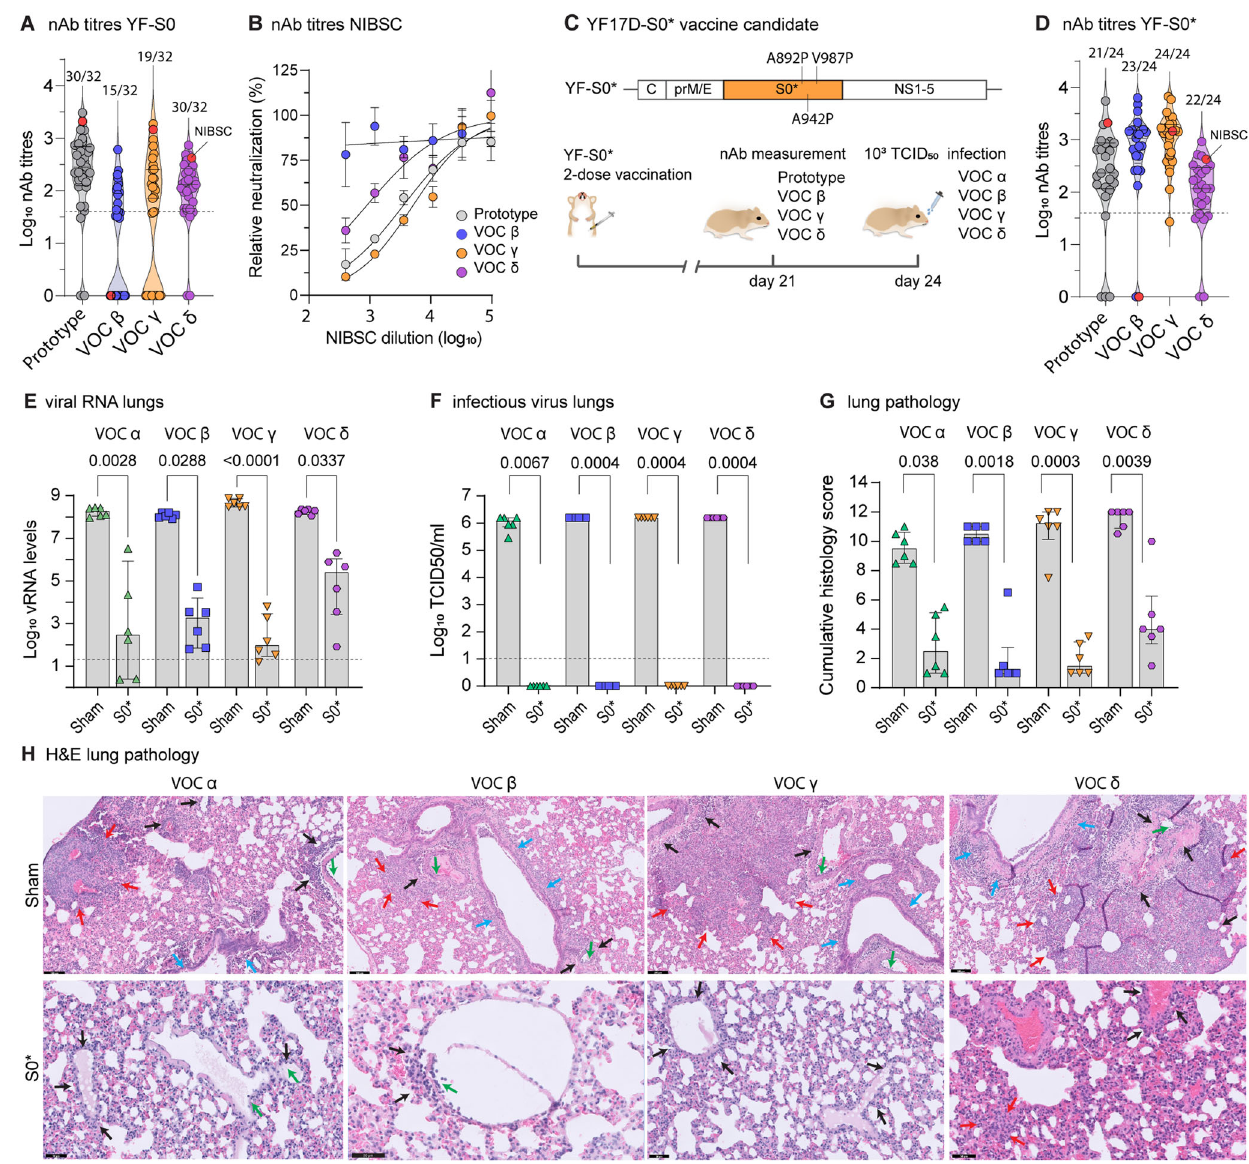
Fig. 2 | A vaccinebasedon updated spikeantigen S0* offersprotectionagainst four VOCs. A nAb titres against prototypic (gray circles), VOC Beta (blue circles), VOC Gamma (orange circles) and VOC Delta (purple circles) spike-pseudotyped virus on day 21 after vaccination with prototype YF-S0. Numbers above individual violinplots indicate animalsseroconverted. Red datapoint indicates the NIBSC 20/ 130 human reference sample. NAb titres against prototypic spike-pseudotyped virus (gray circles) are from Fig. 1B. B Neutralization curves for NIBSC 20/130 human reference sample against same set of pseudotyped viruses. C Schematic of theupdatedYF-S0*(S0*)vaccinecandidatebasedonVOCGamma,plusthreeextra stabilizing proline residues.Vaccination schemewith YF-S0*. Syrianhamsterswere immunized twice intraperitoneally with 10 4 PFU of S0* ( n =24 vaccinated and n =24 sham vaccinated) on day 0 and 7 and inoculated intranasally on day 24 with 10 3 median tissue-culture infectious dose (TCID50) of either VOC Alpha (green triangles),VOCBeta(bluesquares),VOCGamma(orangetriangles),andVOCDelta